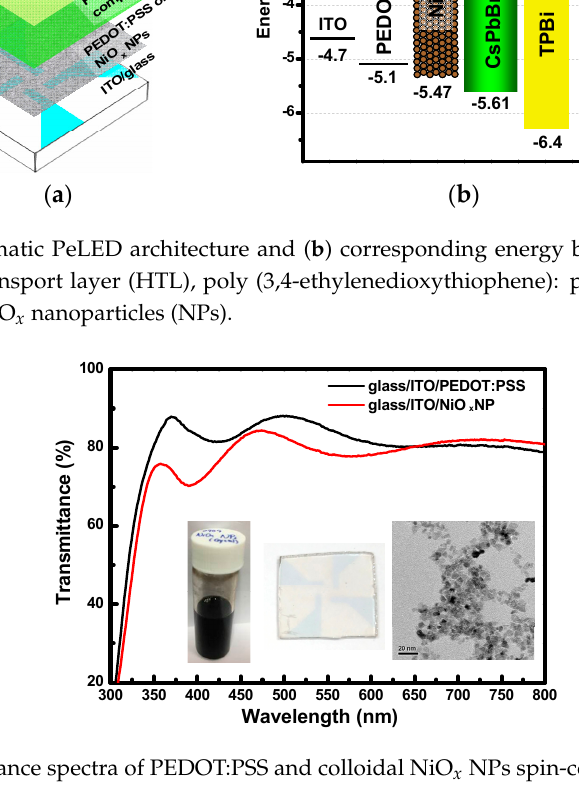
Figure 2. Transmittance spectra of PEDOT:PSS and colloidal NiO x NPs spin-coated on the ITO-glass substrates. Insets from left to right show the photographs of NiO x NP ink and thereby a spin-coated film and the TEM image of NPs. Table 1. Different HTLs and recipes of precursor solution for EML in perovskite LEDs (PeLEDs).